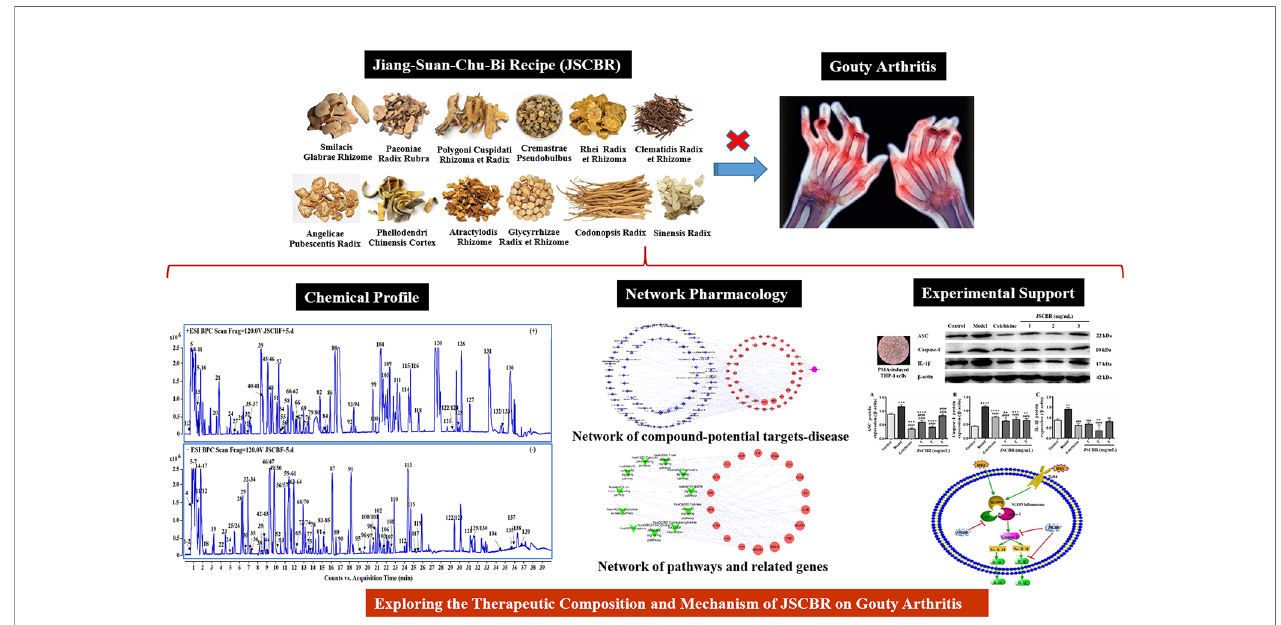
FIGURE 1 | The schematic diagram of the present